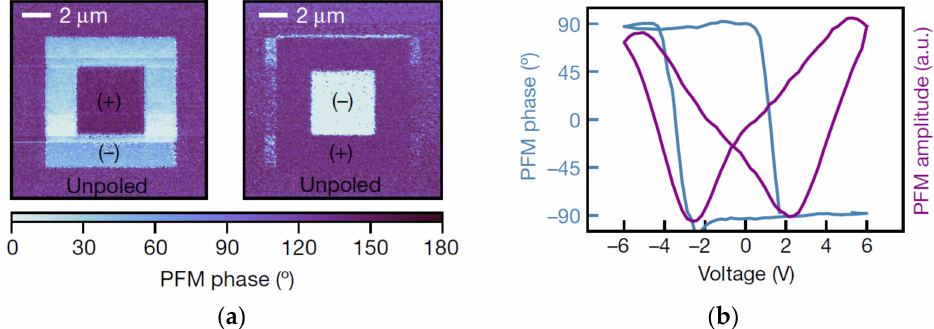
Figure 6. PFM data with electric polarization switching: ( a ) phase-contrast PFM images of 1 nm ferroelectric HZO film and ( b ) phase-amplitude switching spectroscopy loops for a 1 nm ferroelectric HZO film. Reproduced with permission [77]. Copyright 2020, Springer Nature